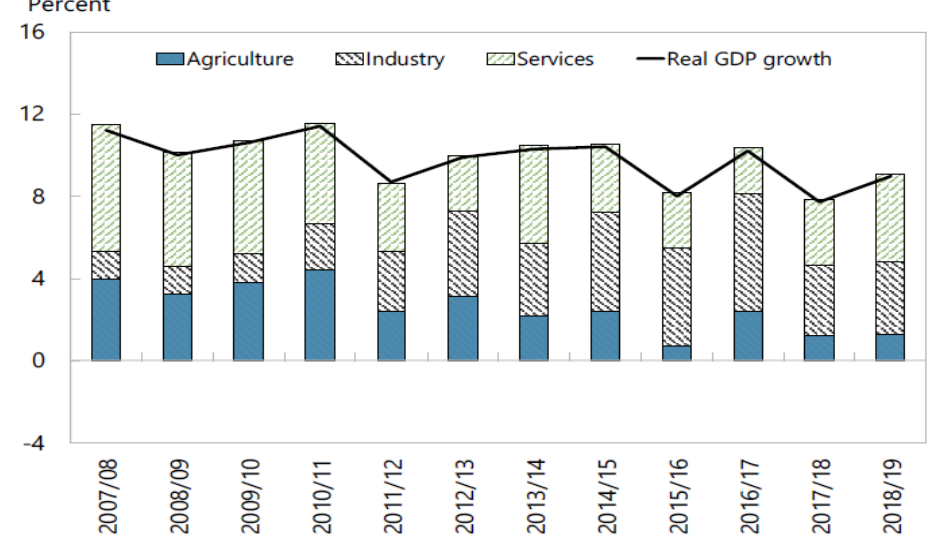
Figure 3. Ethiopian real GDP growth and contribution by sector from 2007 / 08 to 2018 / 19. Source: IMF [76], International Monetary Fund Country Report No. 20 / 29 of the Federal Democratic Republic of Ethiopia.